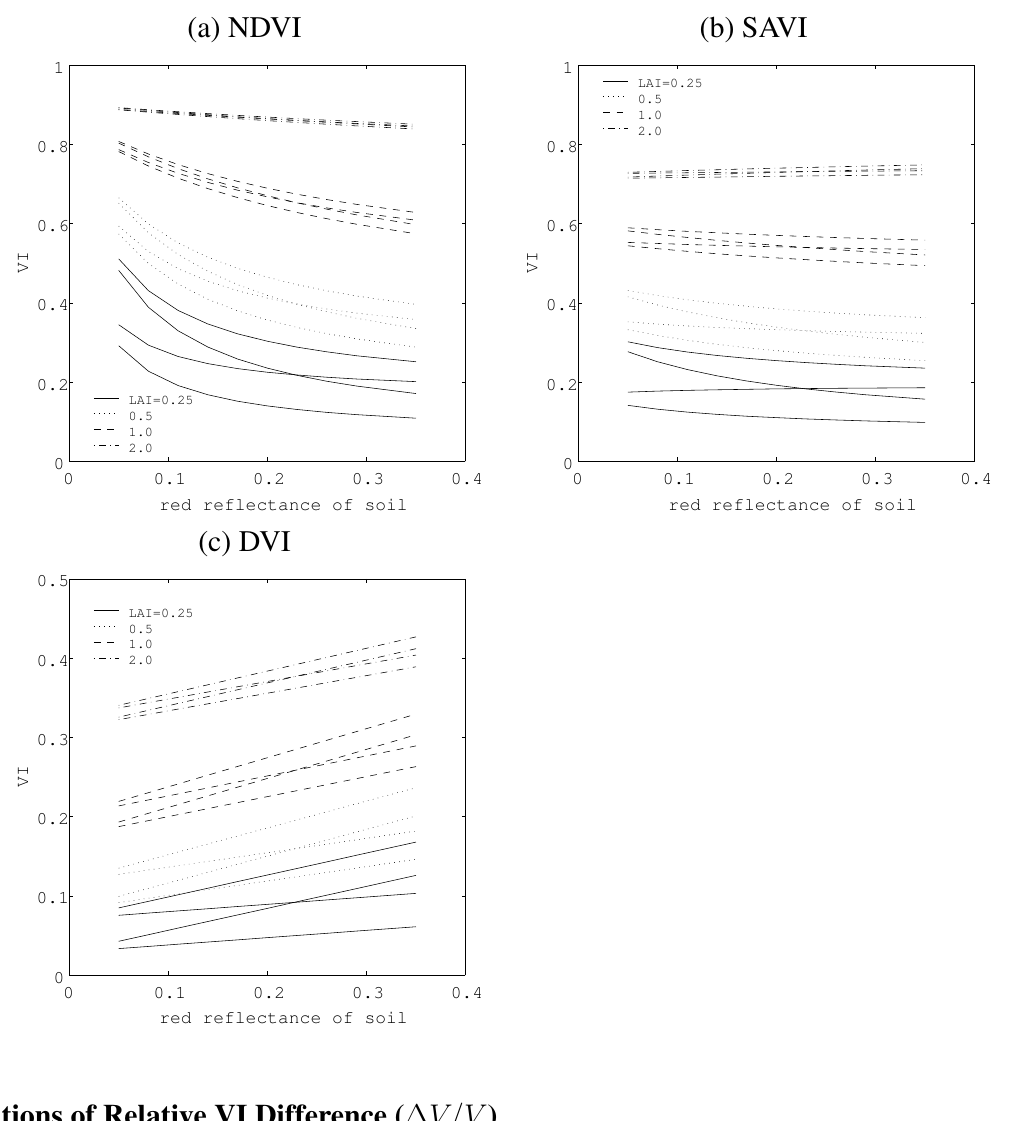
Figure 4. Variations of VI values along with the vegetation isolines based on the four extreme cases of soil line. (a) NDVI, (b) SAVI, and (c)